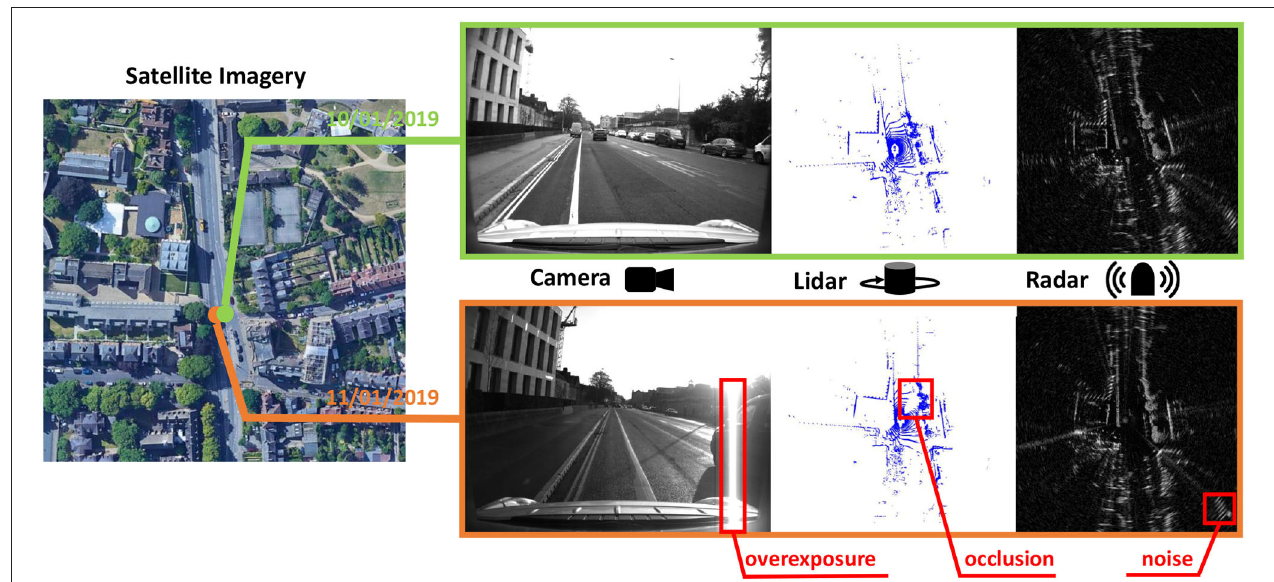
FIGURE 1 | The sensor data collected at the same place but different time. These data are selected from the Oxford Radar RobotCar dataset. Obviously, every sensor has its weakness for long-term robotic